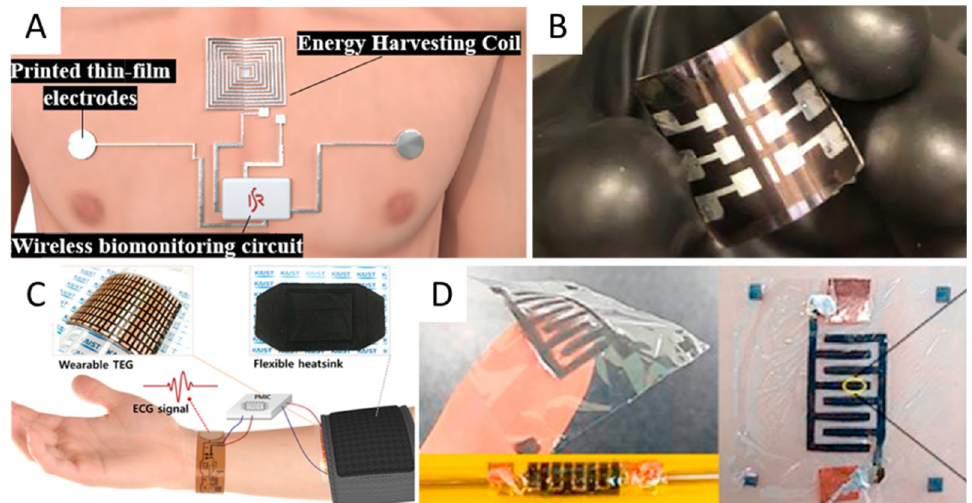
Figure 3. Examples of flexible energy harvesting and storage solutions: ( A ) wireless power transfer (WPT). Reprinted with permission from [149]; ( B ) flexible perovskite tandem photovoltaic cells. Reprinted with permission from [153]; ( C ) self-powered wearable electrocardiography using a wearable thermoelectric power generator. Reprinted with permission from [160]; ( D ) flexible planar micro-supercapacitor. Reprinted with permission from